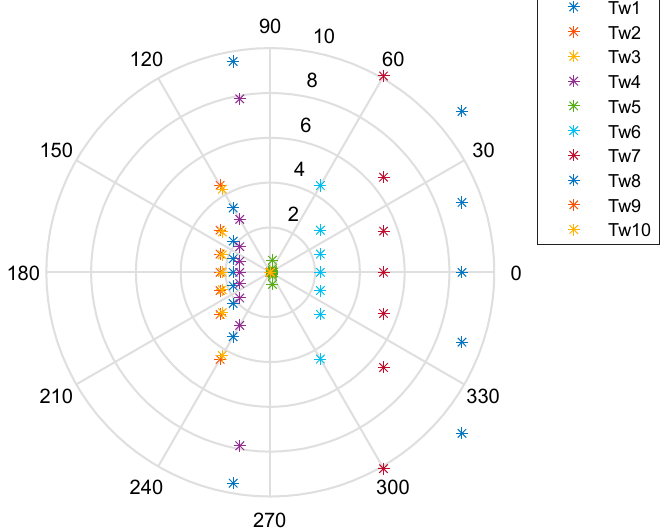
Figure 17. Polar diagram of the synchronism representing ship speeds for di ff erent α angles.